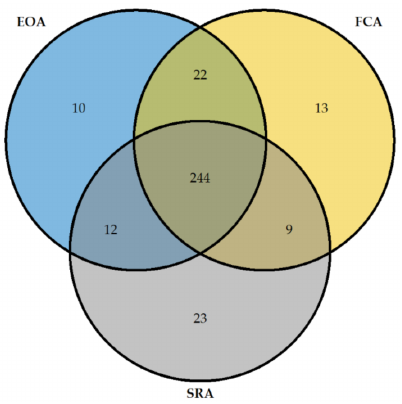
Figure 3. Venn diagram for EOA, FCA, and SRA decisions on 288 patients. This Venn diagram represents the positive and negative decisions. For the SRA, the indeterminate results are not included. Each circle represents one classifier (blue: EOA, yellow: FCA and grey: SRA). The number of agreements between two classifiers is noted in the intersection of two circles, and the number of agreements between three classifiers is noted in the intersection of three circles. The number of decisions taken on the basis of only one classifier is noted in the non-superposed part of the circle. EOA: Expert opinion adjudication, FCA: Functional cytometric assay, SRA: Serotonin release assay, HIT: Heparin-induced thrombocytopenia.